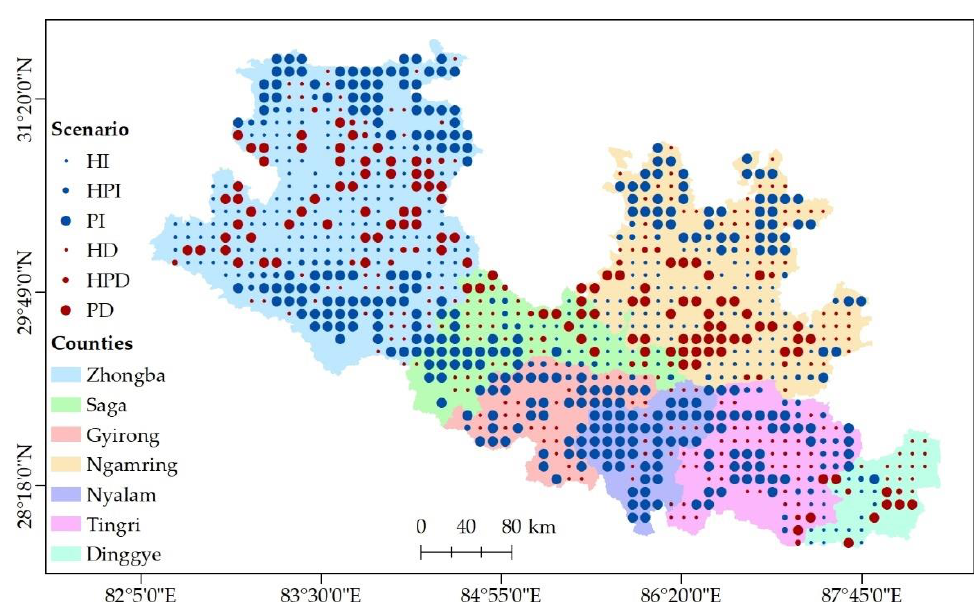
Figure 6. Main drivers of NDVI change in the seven counties of the study area. Different symbols indicate the different significant levels (* P < 0.05; # 0.05 < P < 0.10) according to the partial correlation coefficients. The map was created using ESRI ArcMap 10.7 software; the topographic base of the map was created with National Catalogue Service For Geographic Information data (https://www.webmap.cn, figure number: GS(2016)2556).